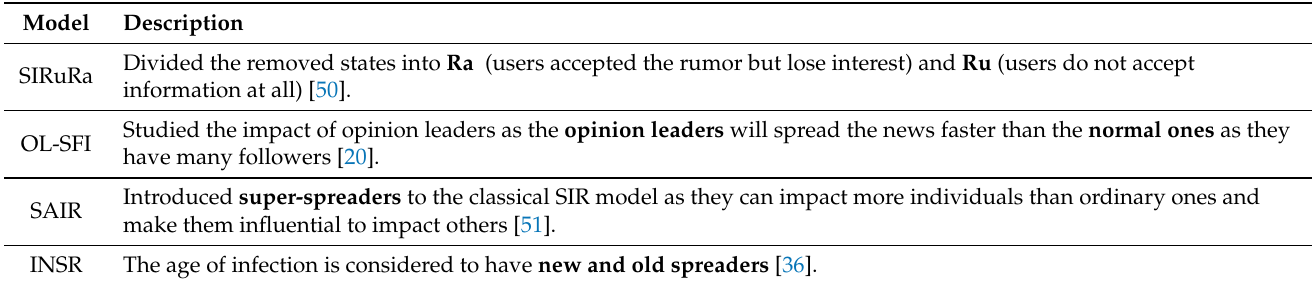
Table 3. Different Modifications to the Classical SIR Model by Branching the Basic